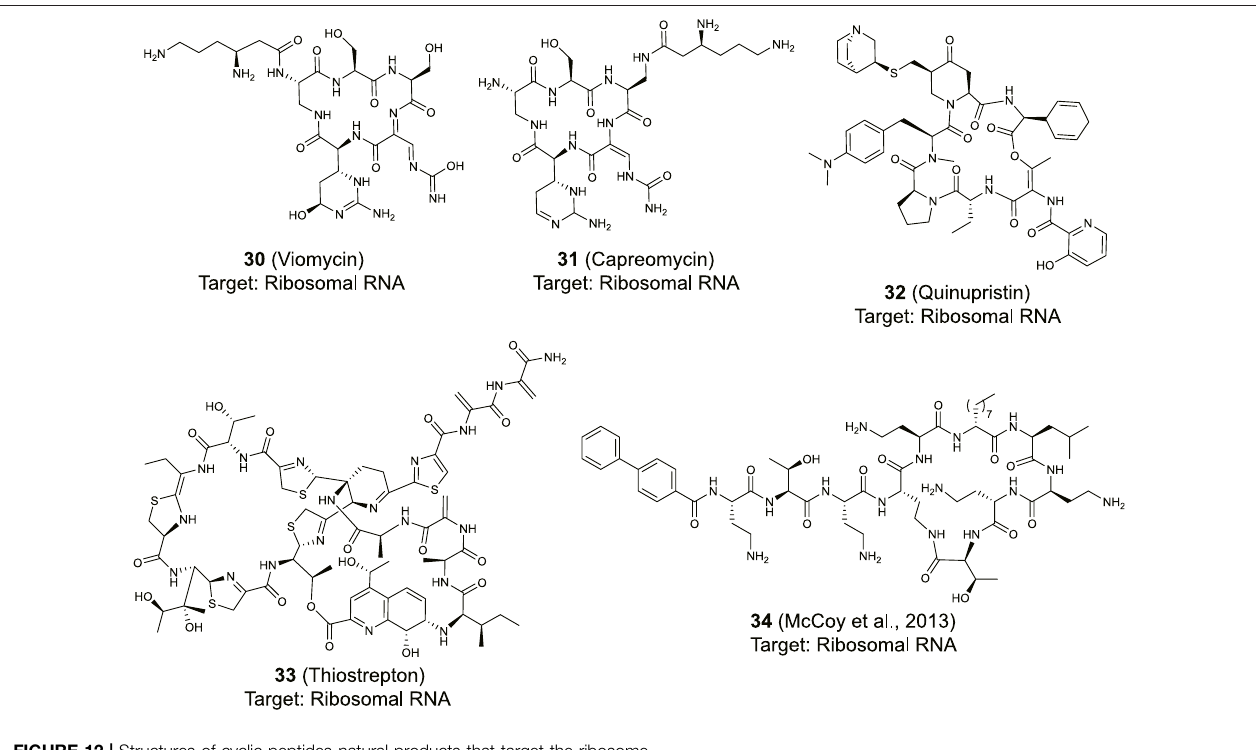
FIGURE 12 | Structures of cyclic peptides natural products that target the ribosome.